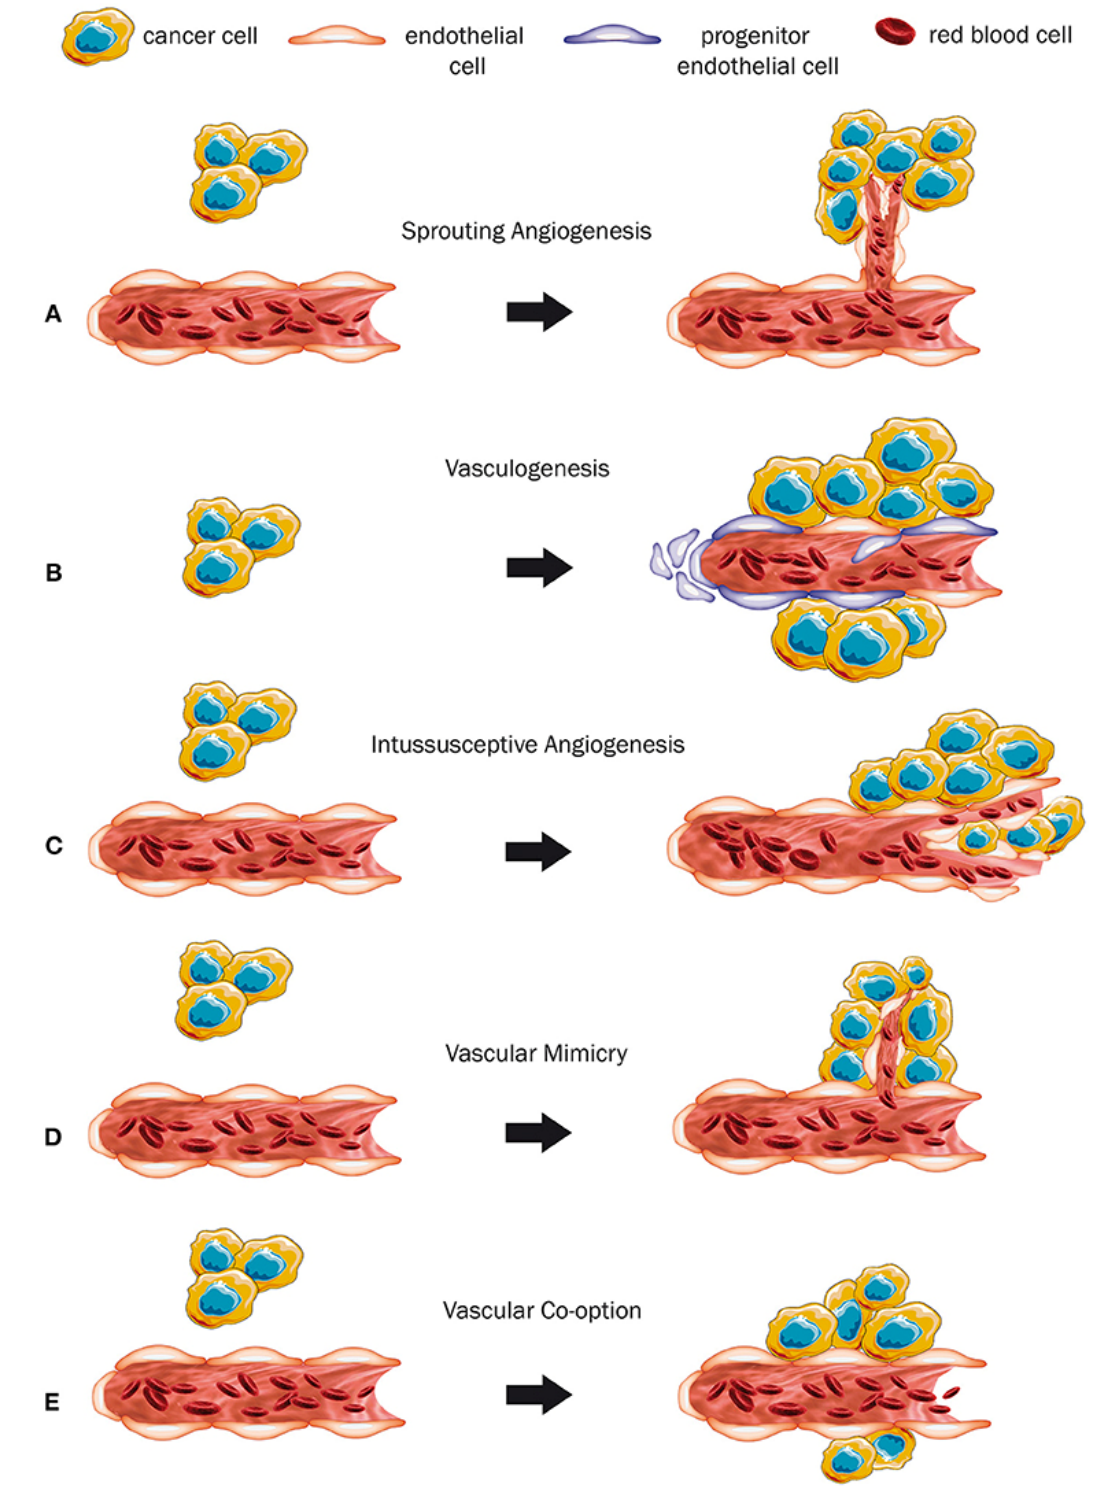
Figure 1. Different neovascularization types due to cancer. ( A ) Sprouting angiogenesis: growth of new capillary vessels out of preexisting ones. ( B ) Formation of primitive vascular structures during embryogenesis via the differentiation of endothelial precursor cells. ( C ) A dynamic intravascular process capable of dramatically modifying the structure of the microcirculation. ( D ) Formation of vascular structures by cancer cells, allowing to generate a channel-network able to transport blood and tumor cells. ( E ) Mechanism in which tumors obtain a blood supply by hijacking the existing vasculature and tumor cells migrate along the vessels of the host organ. (Permission by Haas G, Fan S, Ghadimi M, De Oliveira T, Conradi LC. Different Forms of Tumor Vascularization and Their